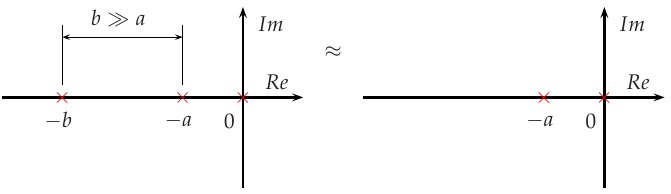
Figure 7. Consideration of pole